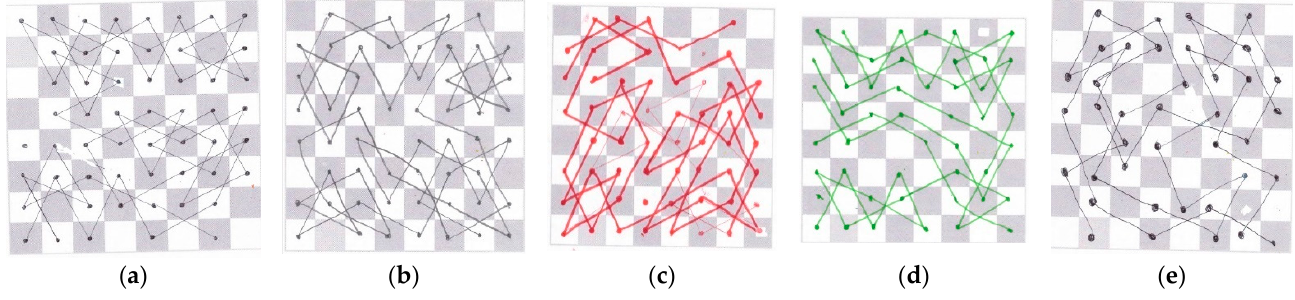
Figure 13. Chess routes with a knight. Drawing made by participant: ( a ) A5; ( b ) A7; ( c ) A3; ( d ) A4; ( e ) A6.